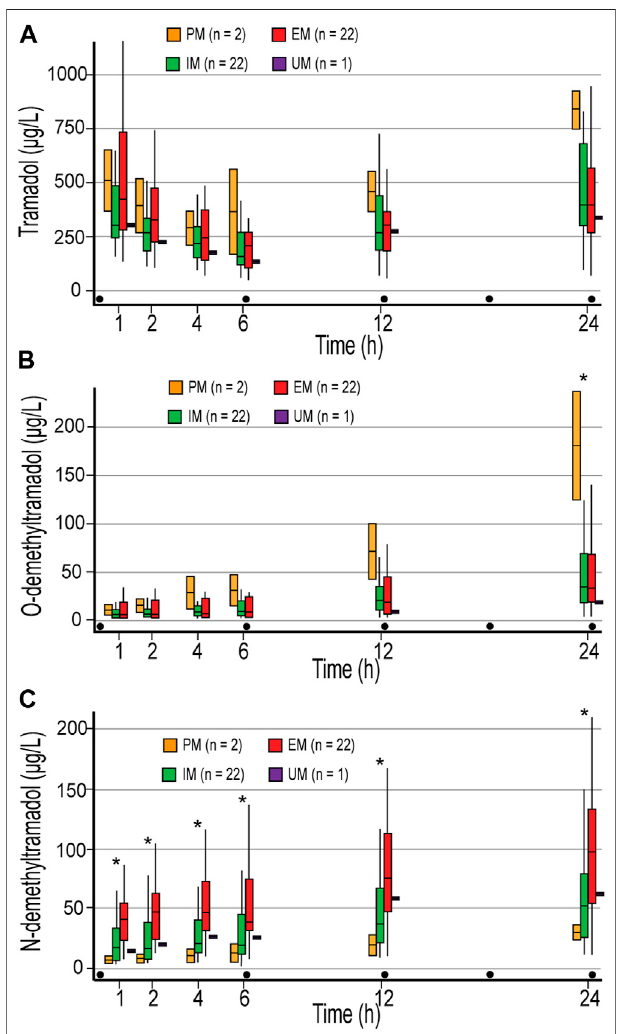
FIGURE 1 | Concentrations of tramadol (A) , O -demethyltramadol (B) , and N -demethyltramadol (C) in the fi rst 24 postoperative hours. Concentrations were measured 1, 2, 4 h after the fi rst dose of 100 mg tramadol iv, and just before the second (time point 6 h), third (time point 12 h), and fi fth (time point 24 h) doses of tramadol. PM, poor metabolizer; IM, intermediate metabolizer; EM, extensive metabolizer; UM, ultrafast metabolizers; Dot: tramadol 100 mg IV injections; * statistically signi fi cant differences (Mann-Whitney U test) between PM and EM/IM (B) , and EM and IM/PM (C) .